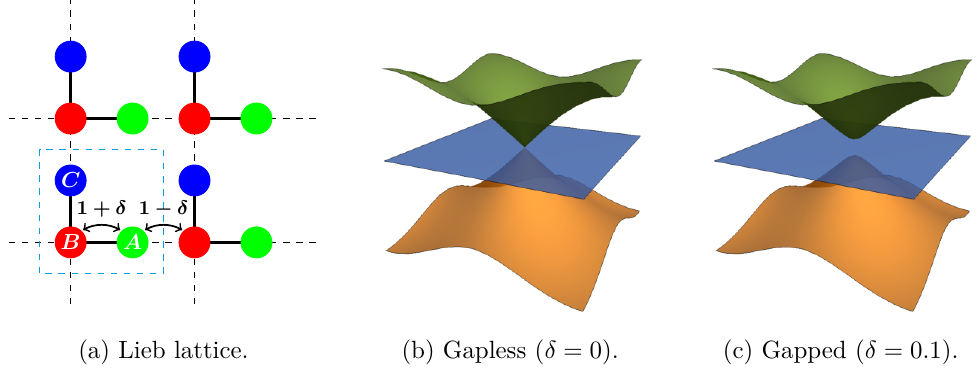
Figure 1 . Lieb lattice and its band structure. (a) Lieb lattice. (b) The energy band for δ = 0 has a Dirac cone and a flat band. (c) δ generates a gap between the upper and lower bands. The ideal flat band model should have a flat that is band well separated from other bands. Only in such case, observed phenomena can be safely attributed to the flat